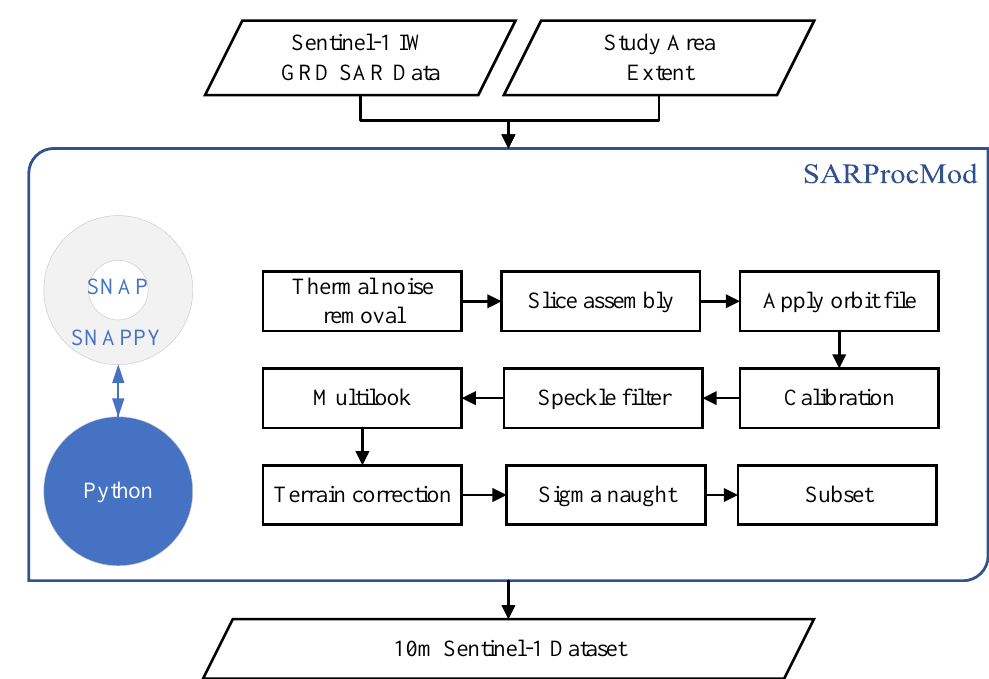
Figure 6. The flowchart for the SARProcMod for Sentinel-1 SAR pre-processing